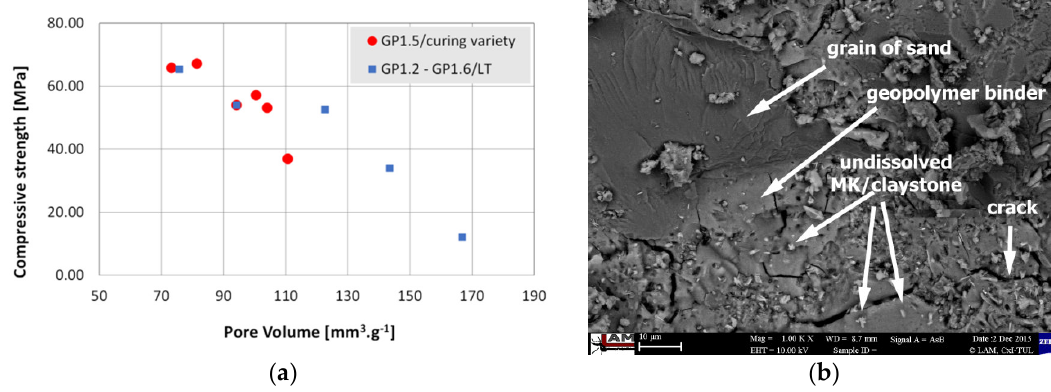
Figure 8. ( a ) Dependence of the compressive strength on the pore volume of the geopolymers; ( b ) SEM image of the GP1.5/LT after the compressive strength measurement. The scale bar is 10 µm long.